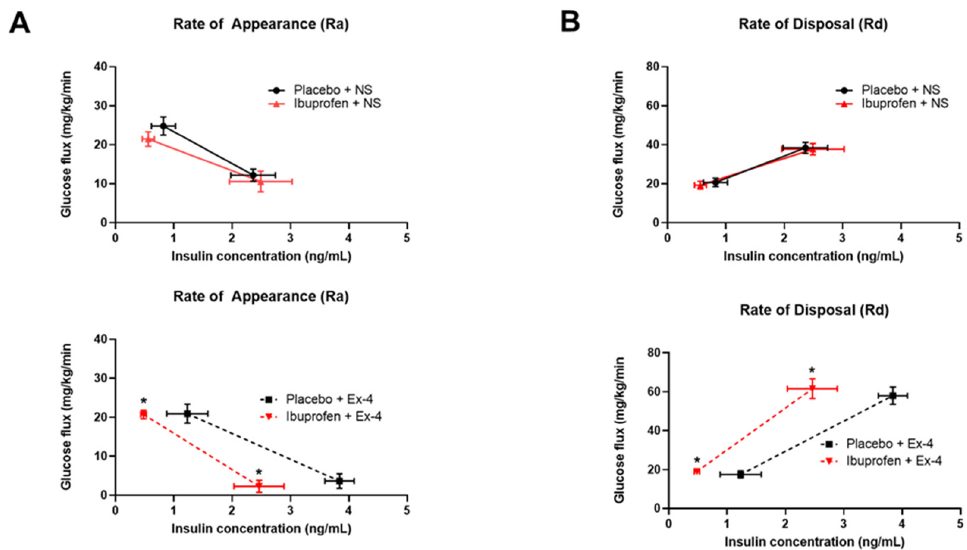
Figure 7. GLP-1 agonist (Exendin-4) improves insulin-mediated glucose appearance and disposal in mice treated with ibuprofen. C57 Blc/6J male mice were placed on a high-fat diet (HFD) and treated with PBS (Placebo) or ibuprofen (Ibp) for 2 weeks, and then a daily injection of (Exendin-4) was administered IP at (24 nmol/Kg) vs. normal saline (NS) for 5 days before undergoing the hyperinsulinemic-euglycemic clamp experiment. The ( A ) glucose appearance rate and ( B ) glucose disposal rate expressed in (mg/kg/min) in relation to the insulin levels expressed in (ng/mL). n = 8 (Placebo + NS), 6 (Placebo + Ex-4), 8 (ibuprofen + NS), and 6 (ibuprofen + Ex-4). All results are presented as mean ± SEM (error bars). Student’s t test was used to compare means between the (Ex-4) treated groups. Statistical significances are denoted with asterisks as follows: *, p ≤ 0.05.